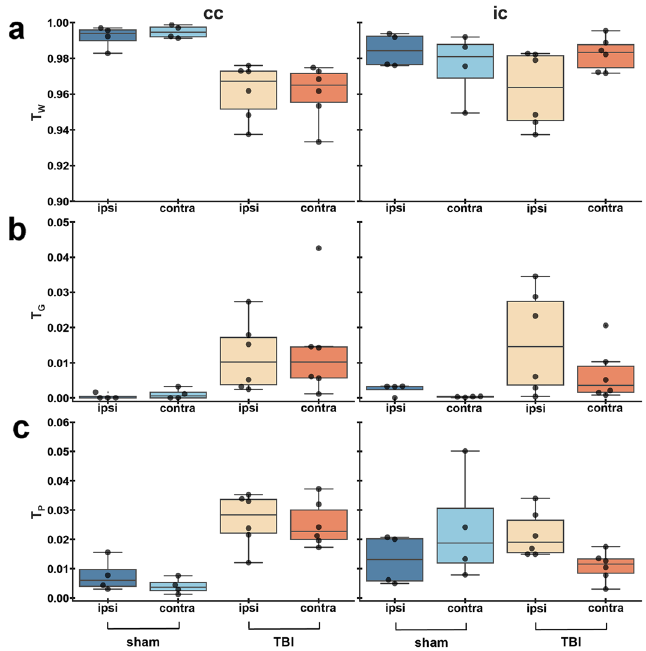
Figure 4. Relative 3-tissue signal fractions in white matter areas. Results are shown as minimum, lower quartile, median, upper quartile and maximum. Results of the compositional analysis are shown in Table 1. Abbreviations: cc; corpus callosum; ic, internal capsule; T W , T G and T P , signal fraction maps representative of white matter, grey matter, and PBS,